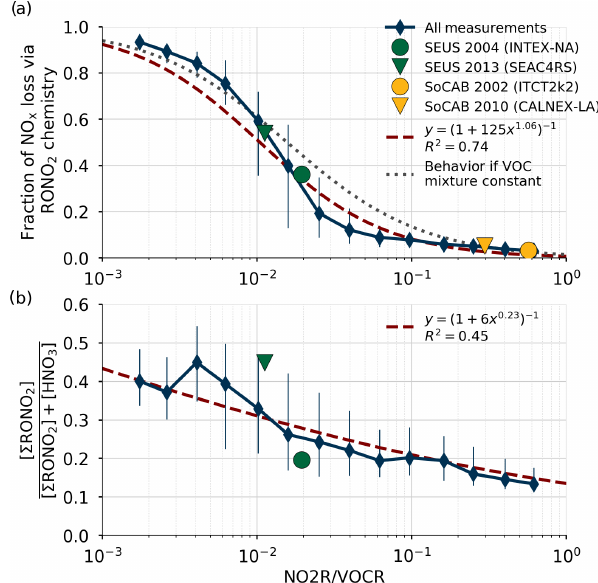
) as a , Y RO 2eff eff